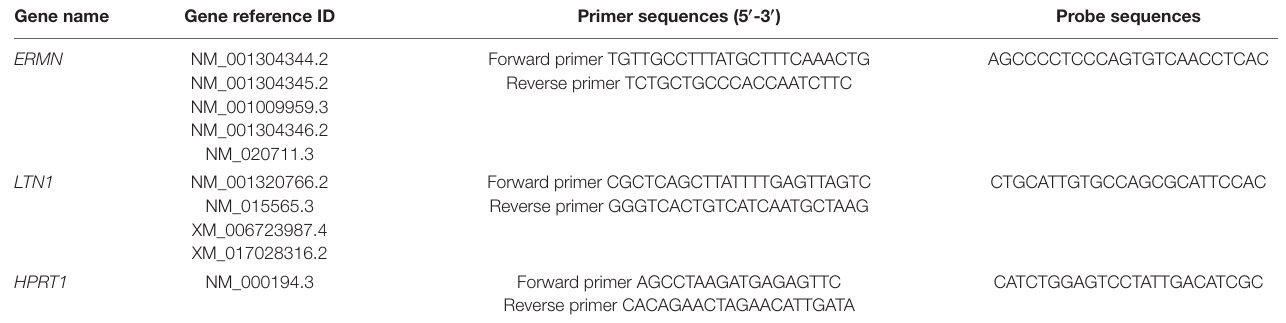
TABLE 1 | Primers and probes used for expression assays.